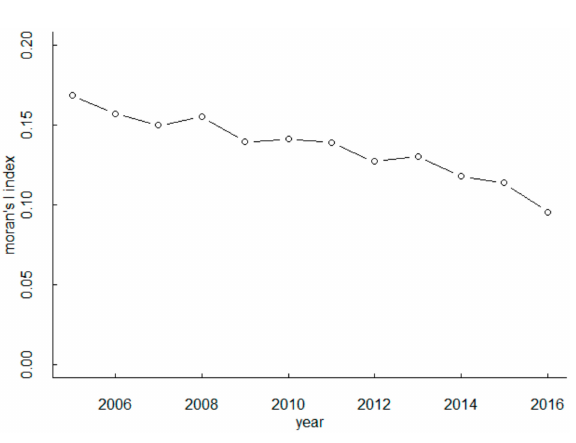
Figure 1. Trend of Moran’s I